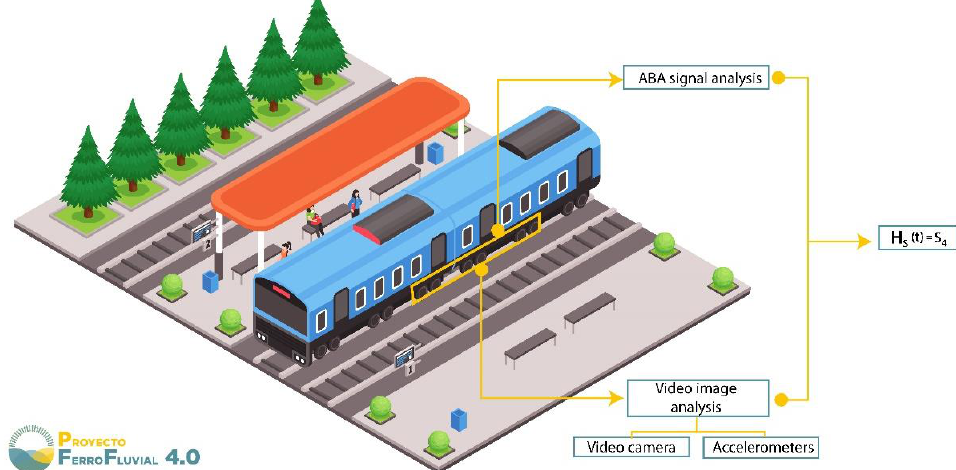
Figure 10. Physical architecture for obtaining train real-time data for a decision-support approach proposed in [108].